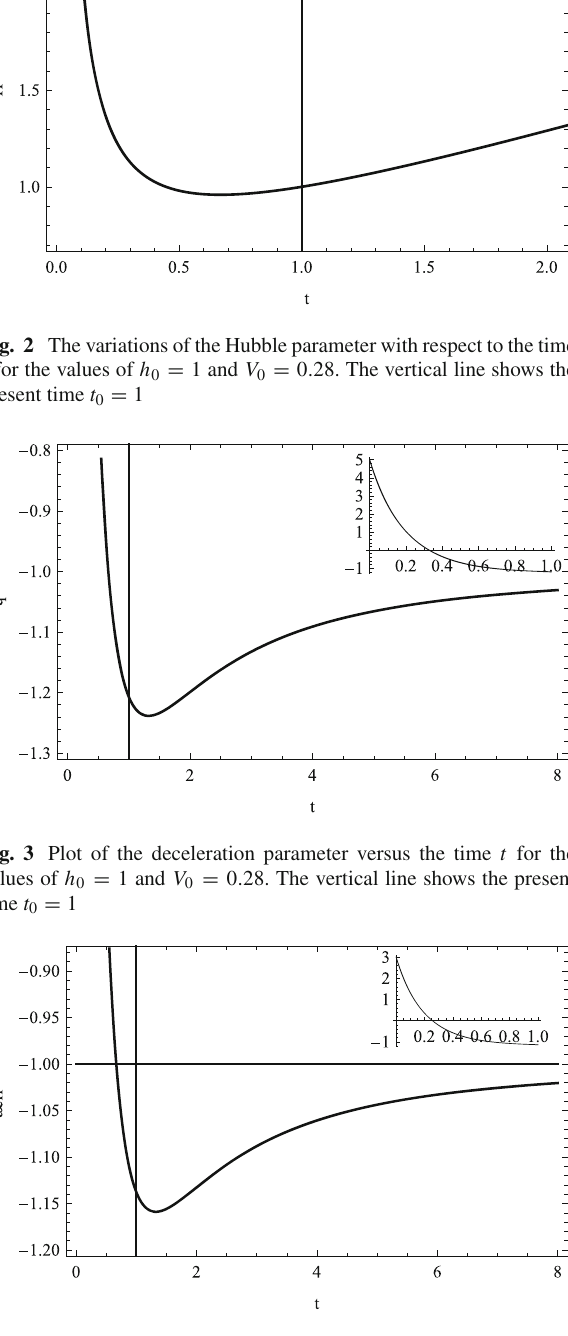
Fig. 4 The behavior of the effective equation of state parameter with respect to the time t for the values of h 0 = 1 and V 0 = 0 . 28. The vertical line shows the present time t 0 =